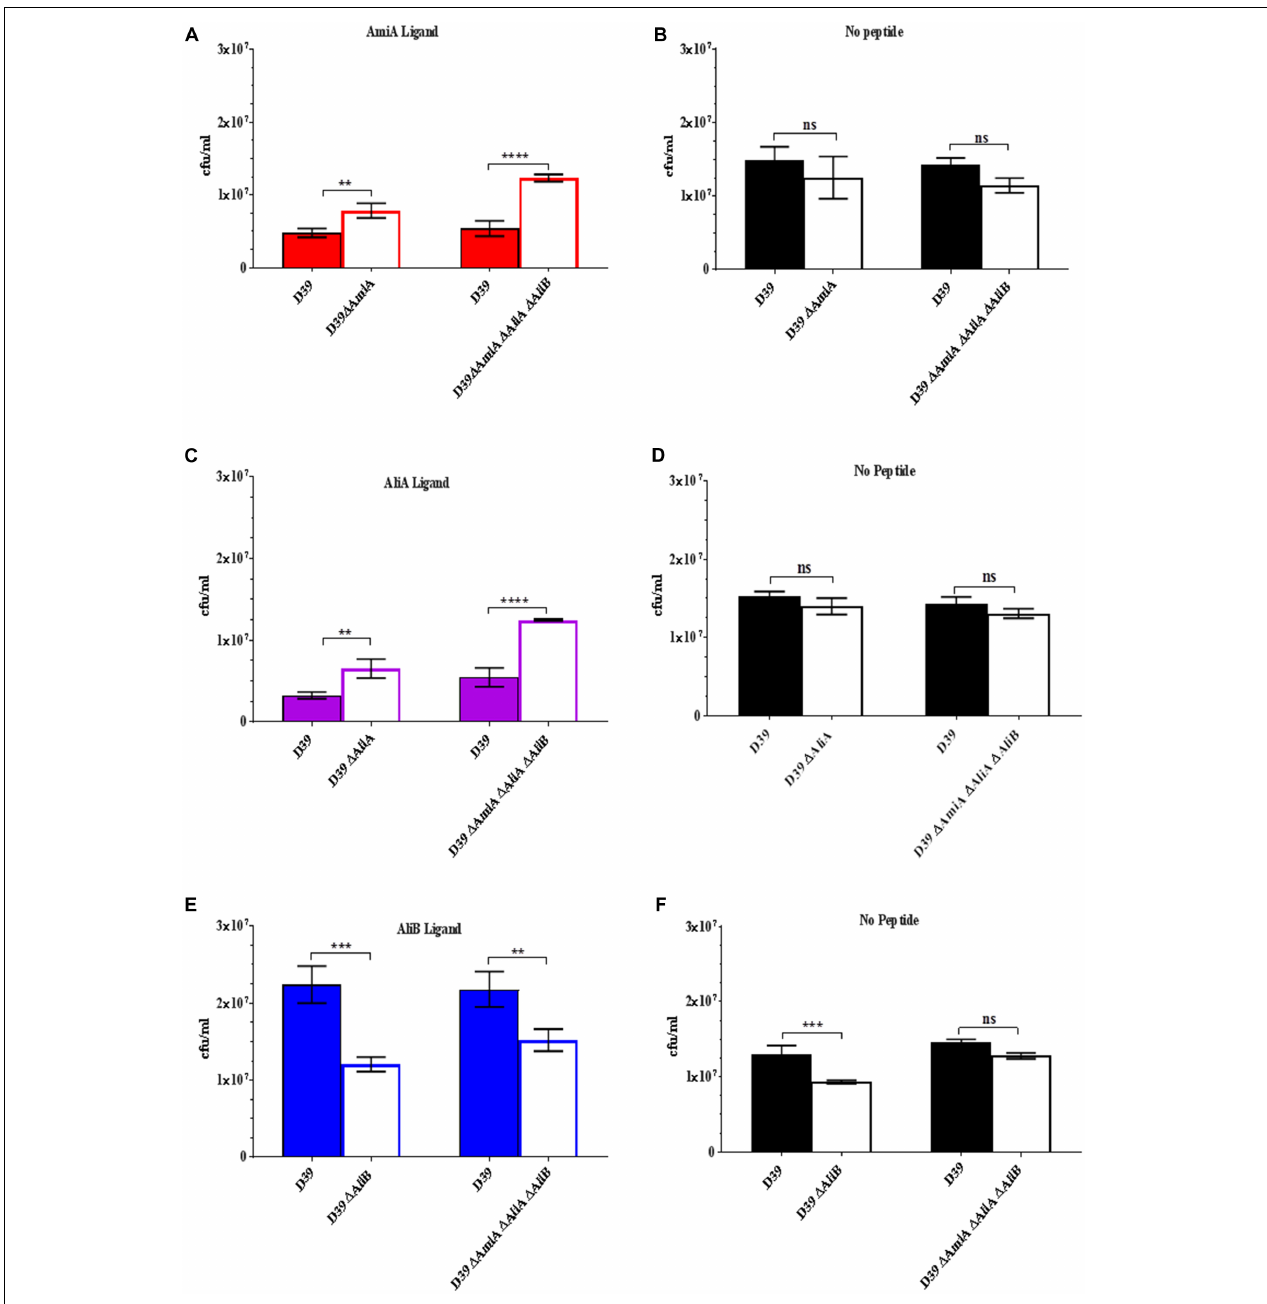
FIGURE 2 | Competition assay between D39 and each of its mutants when cultured together in the absence and presence (0.5 mg/mL) of each of the peptides. Strain D39 was cultured together with mutant (cid:49) AmiA or the triple mutant (cid:49) AmiA/ (cid:49) AliA/ (cid:49) AliB in panel (A) the presence or (B) absence of AmiA ligand, with mutant (cid:49) AliA or (cid:49) AmiA/ (cid:49) AliA/ (cid:49) AliB in panel (C) the presence or (D) absence of AliA ligand and with mutant (cid:49) AliB or the triple mutant (cid:49) AmiA/ (cid:49) AliA/ (cid:49) AliB in panel (E) the presence or (F) absence of AliB ligand in CDM. When OD 600nm reached 0.3, the bacteria were plated onto CSBA with and without antibiotics to differentiate between the wild type and mutants and CFU counted. Results are as the mean ± SD of three independent experiments, ∗∗ p = 0.0021; ∗∗∗ p = 0.00021; ∗∗∗∗ p < 0.0001; ns, not significant.